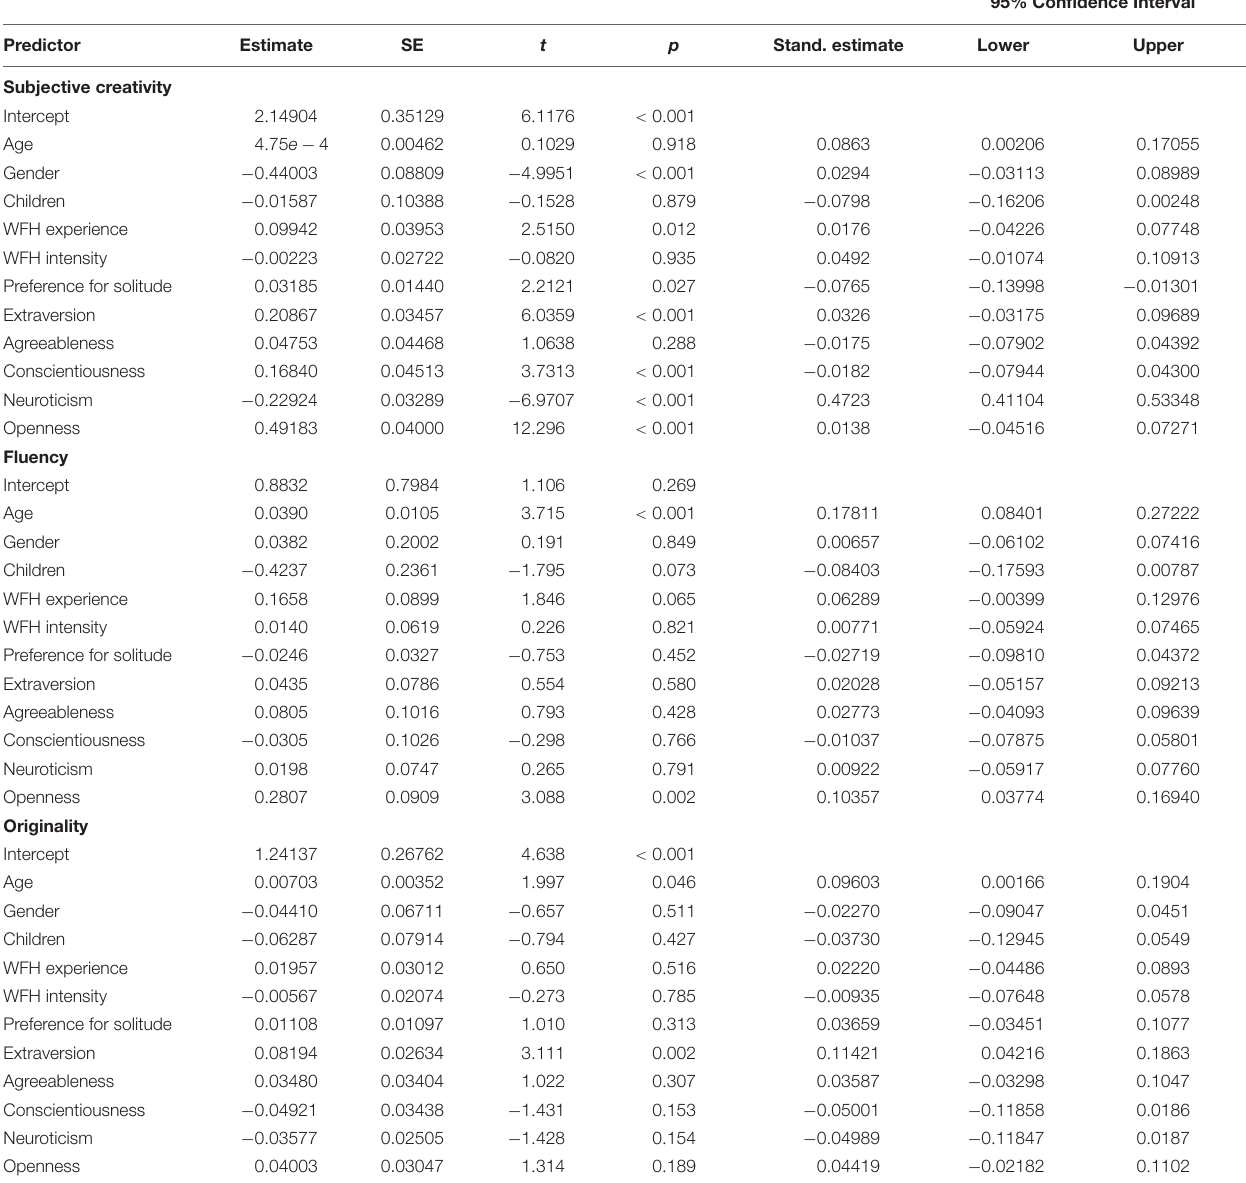
TABLE 4 | Hierarchical multiple regression analyses for measures of creative